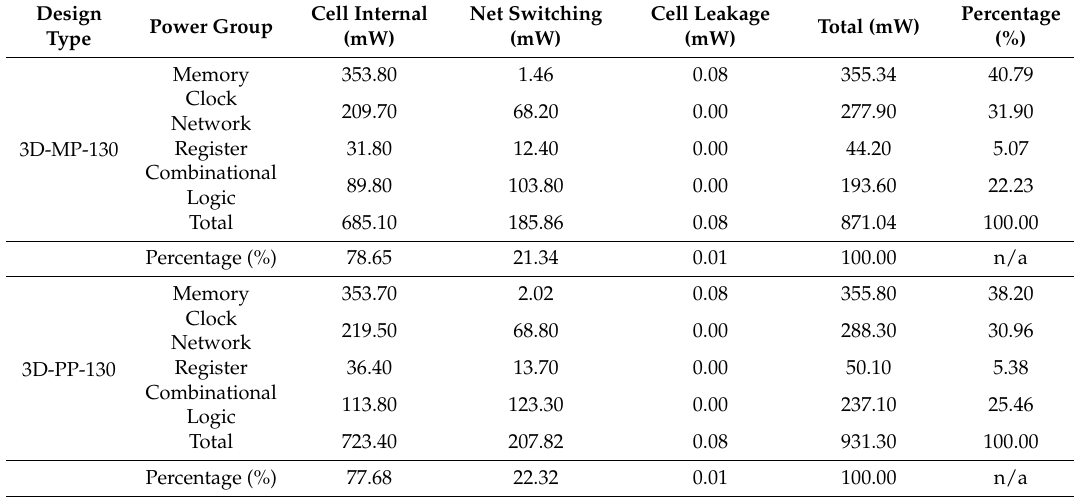
Table 9. Detailed power comparisons of 2D and 3D ICs designed in 45-nm